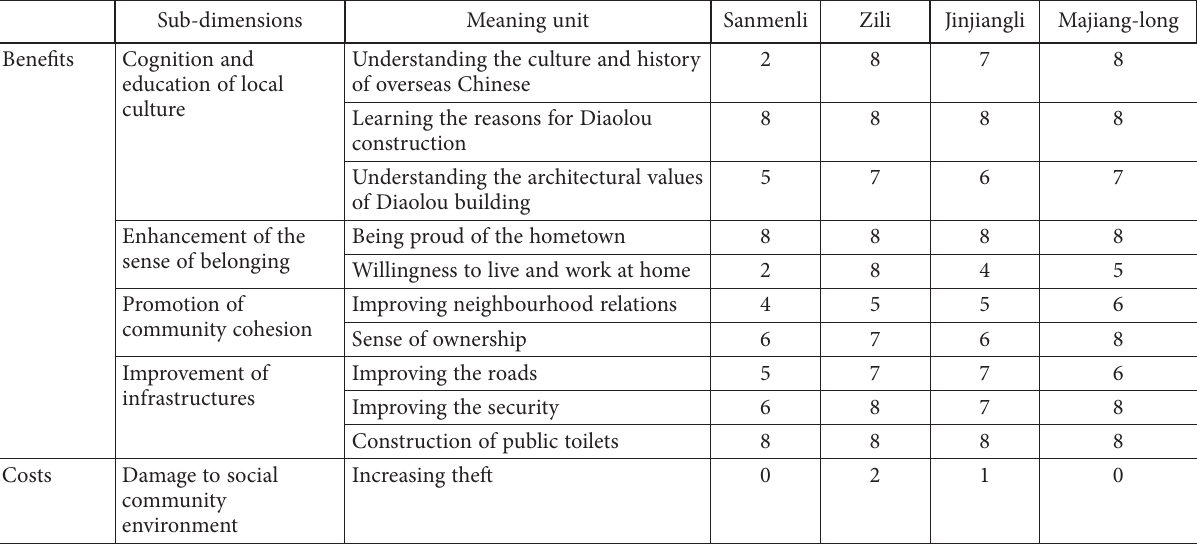
Table 5. Impacts of the WHL inscription from the social and cultural aspect (source: field survey) Sub-dimensions